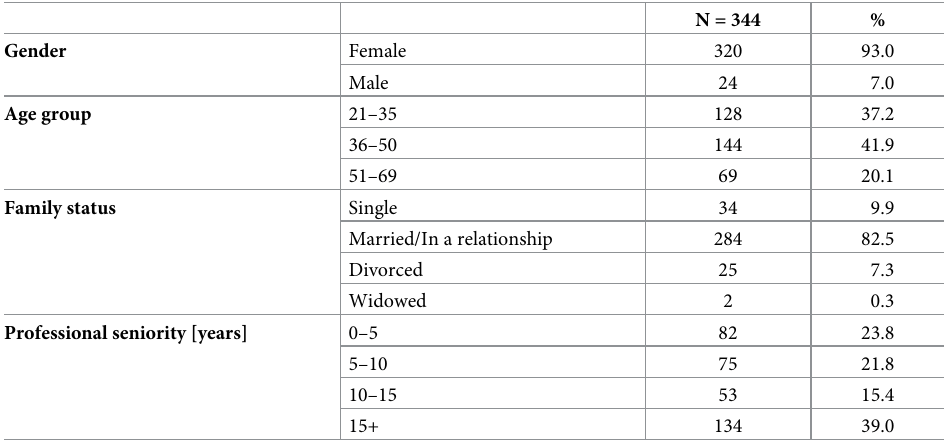
Table 1. Descriptive statistics of the demographic variables in the study